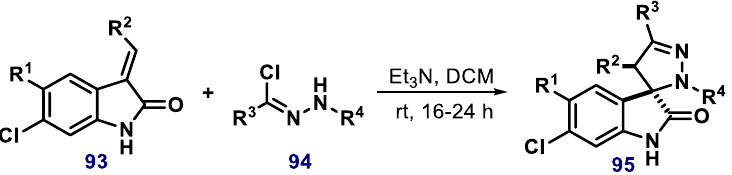
Figure 7. Structure of DS-3032b, a MDM2 inhibitor.